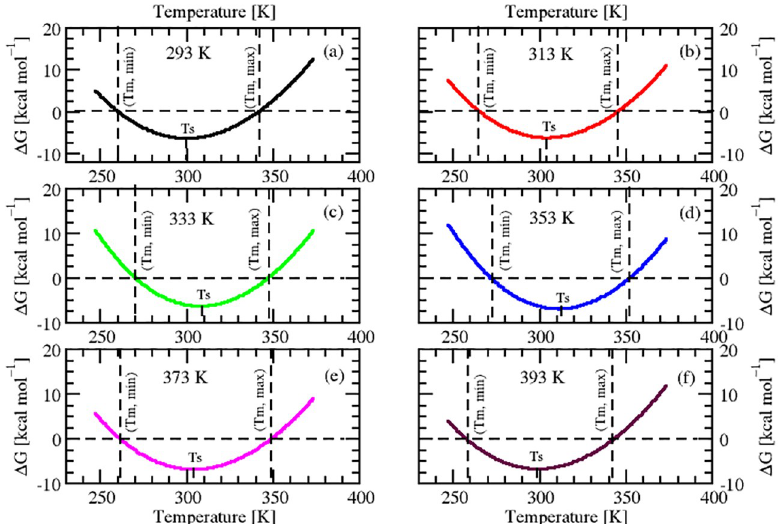
Fig 6. Stability curves of SazCA. Stability curves of different conformational ensembles of SazCA illustrating the temperature dependence of the folding free energy Δ G. Temperatures of cold unfolding T and temperature of maximum stability T